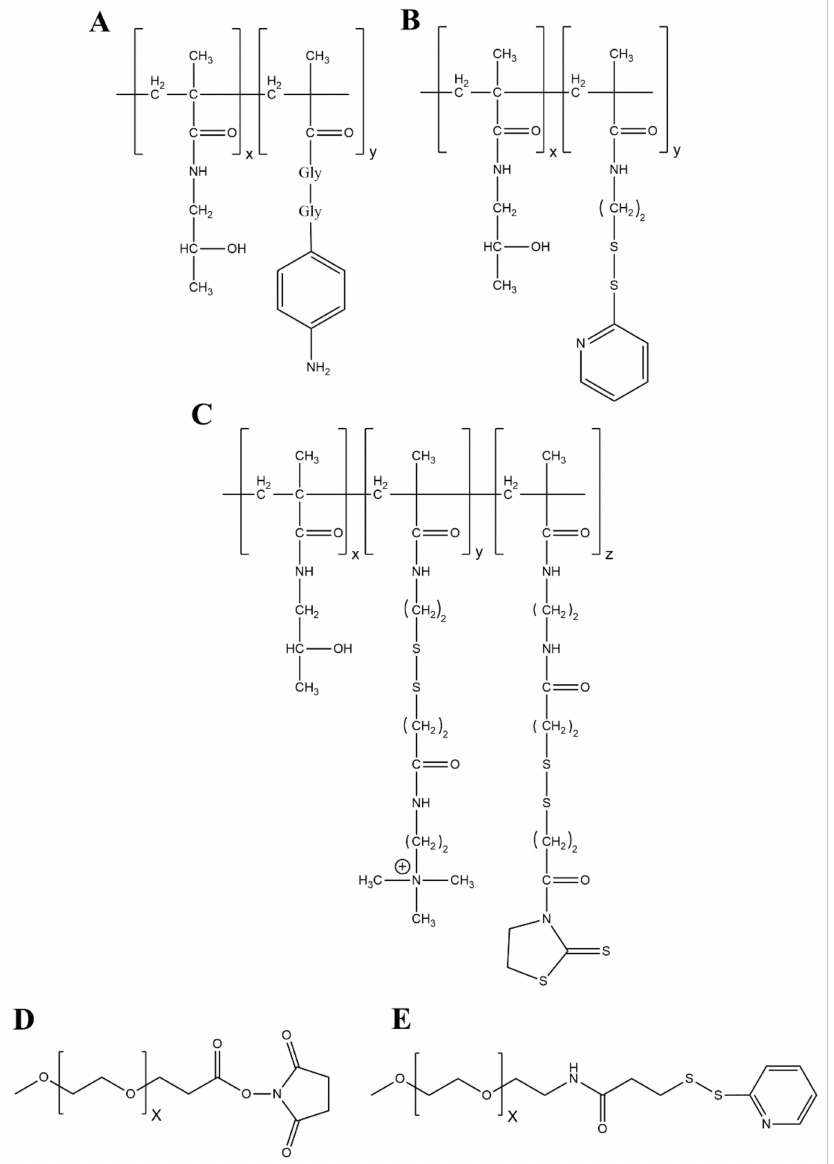
Figure 3. HPMA copolymer and PEG structures. ( A ) HPMA copolymer activated with a diglycine- linked ONp as presented by Fisher et al. [90]. ONp as an amine-reactive group will covalently bind to ε -amino groups of lysine residues on the capsid surface. Commonly used ratio for the